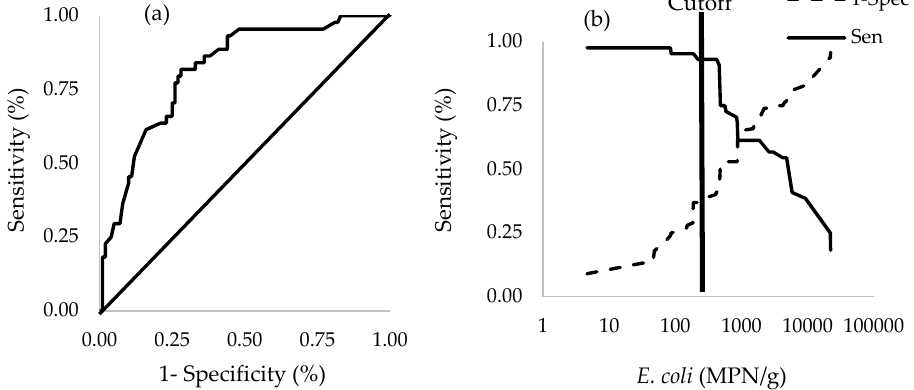
Figure 7. Accuracy for using EC to predict Salmonella contamination in pooled oyster samples: ( a ) ROC curve; ( b ) sensitivity and specificity for using EC concentration (MPN/g oyster meat) to predict Salmonella contamination in oysters, with a vertical line indicating the optimal cutoff value of 420 EC (MPN/g) based on the Youden index. Table 5. Logistic regression model for factors associated with Salmonella in pooled oyster samples from Phang Nga Bay, southern Thailand, March 2016 to February 2017.